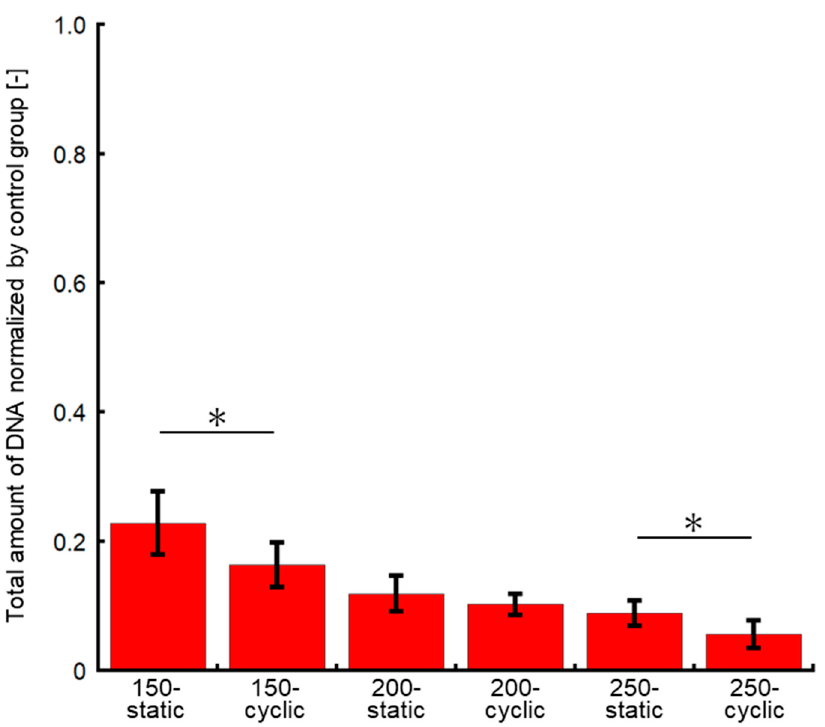
Figure 6. Quantity of DNA normalized by control group in precipitated cells at 24 h. Data are presented as mean ± S.D., n = 5. * indicates significant differences between static and cyclic groups at the same pressure (*: p < 0.05).